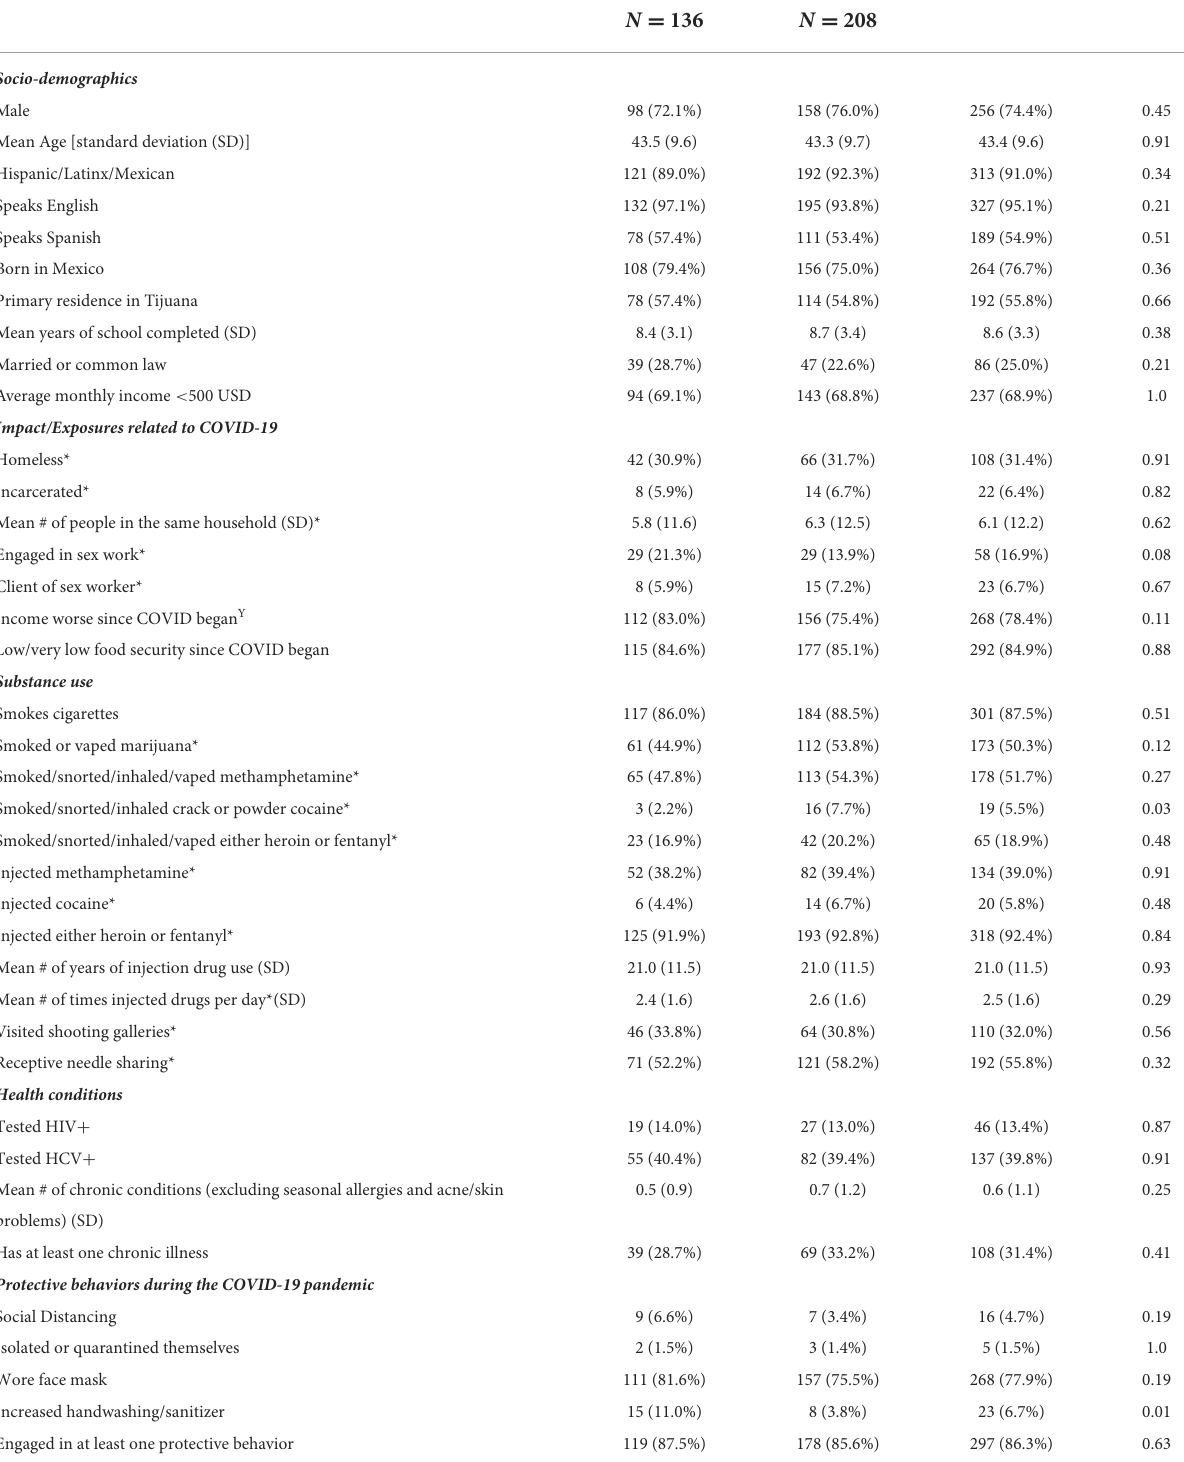
TABLE 1 Characteristics Associated with COVID-19 Vaccination among PWID in Tijuana, Mexico ( n = 344). Baseline